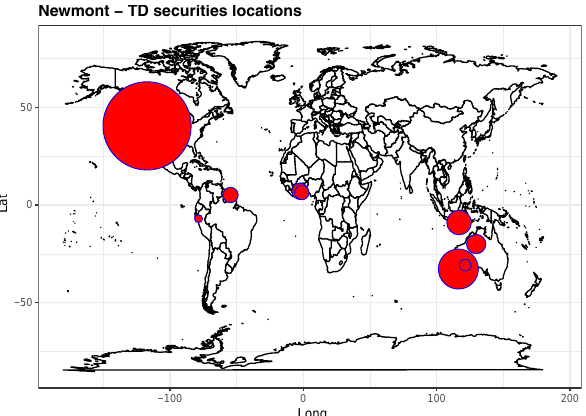
Figure A6. Map of Newmont Corporation assets reported in TD Securities